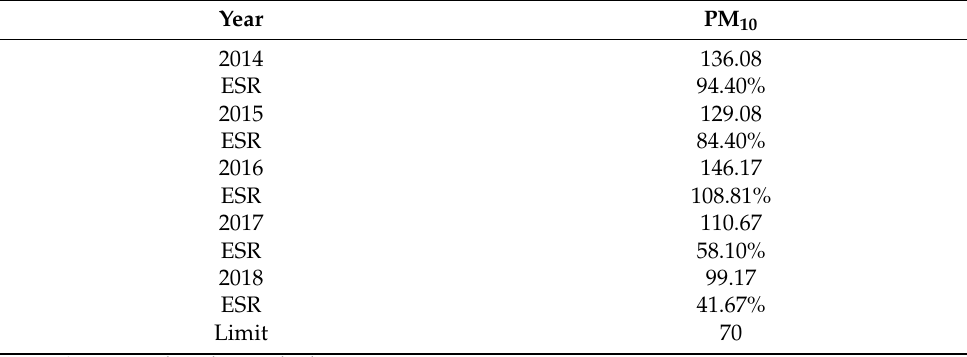
Table 1. Annual average concentration of PM 10 and exceeding standard rate.